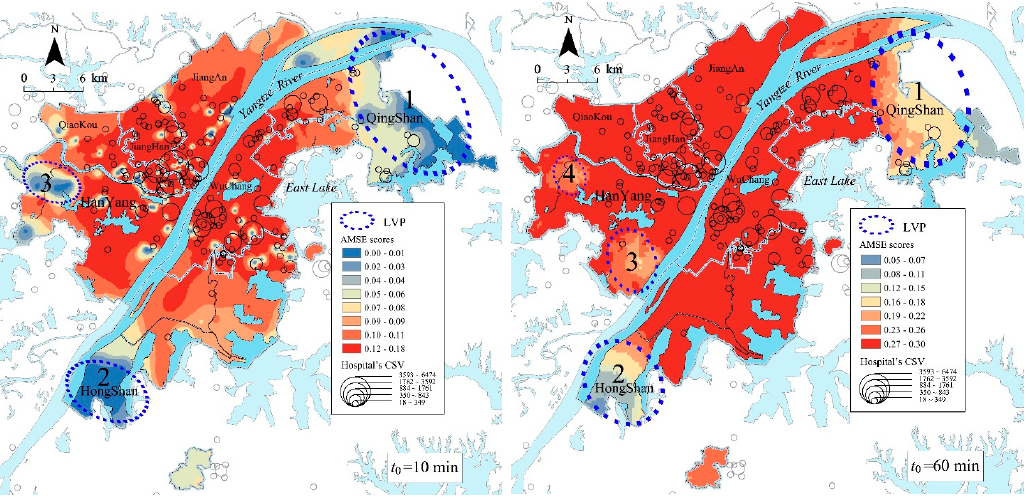
Figure 7. Spatial accessibility of medical services for the elderly (AMSE) scores, general hospital’s medical services comprehensive supply volume (MSCSV) and three low-value plaques (LVPs) of central urban districts for the two threshold times.